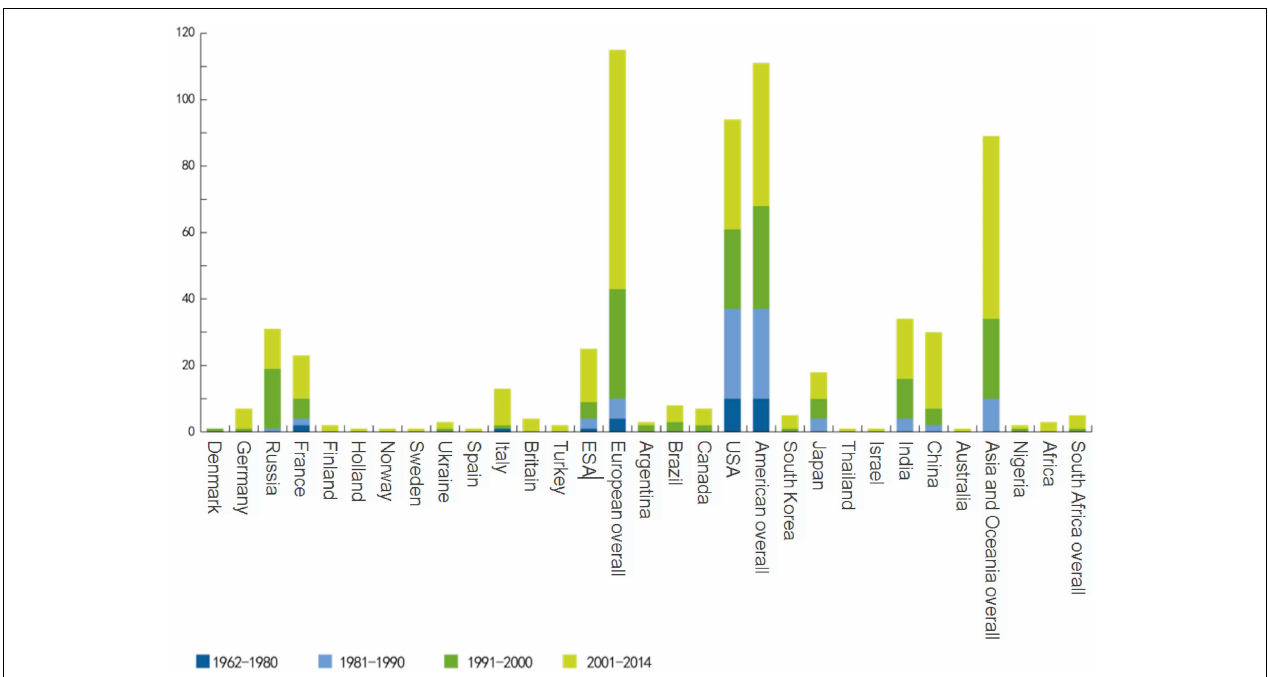
FIGURE 1 | Summary of remote sensing satellites by nation or